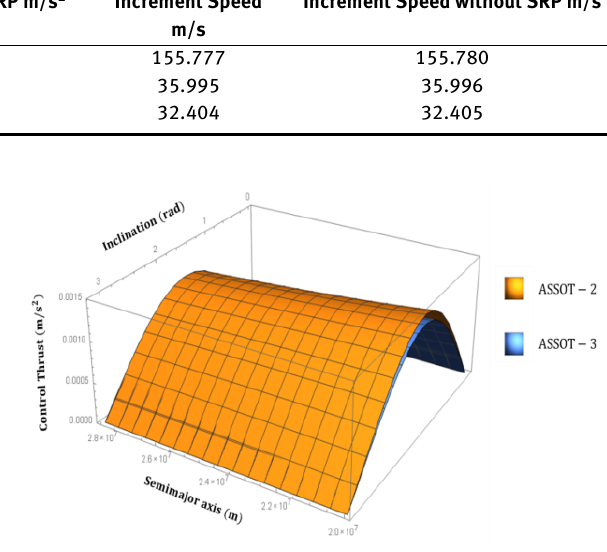
Table 2. Control Thrusts and Characteristic Speeds of all Control Strategies Technique